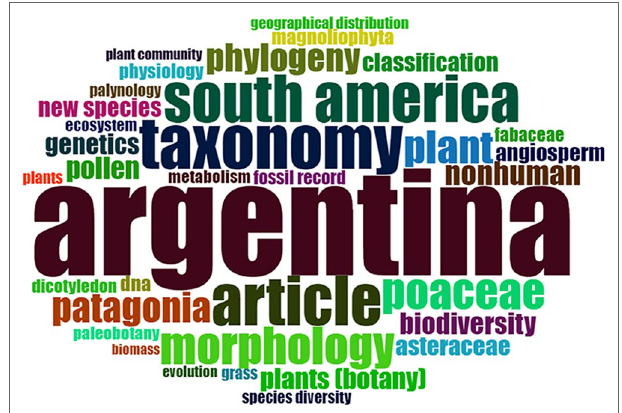
FIGURE 1 | Keywords cloud based on the bibliometric analysis of publications stored at Scopus database from 1993 to 2018 (refer to the text to see filters of the search). Size of the word indicates the frequency of the word in the abstract and/or title.